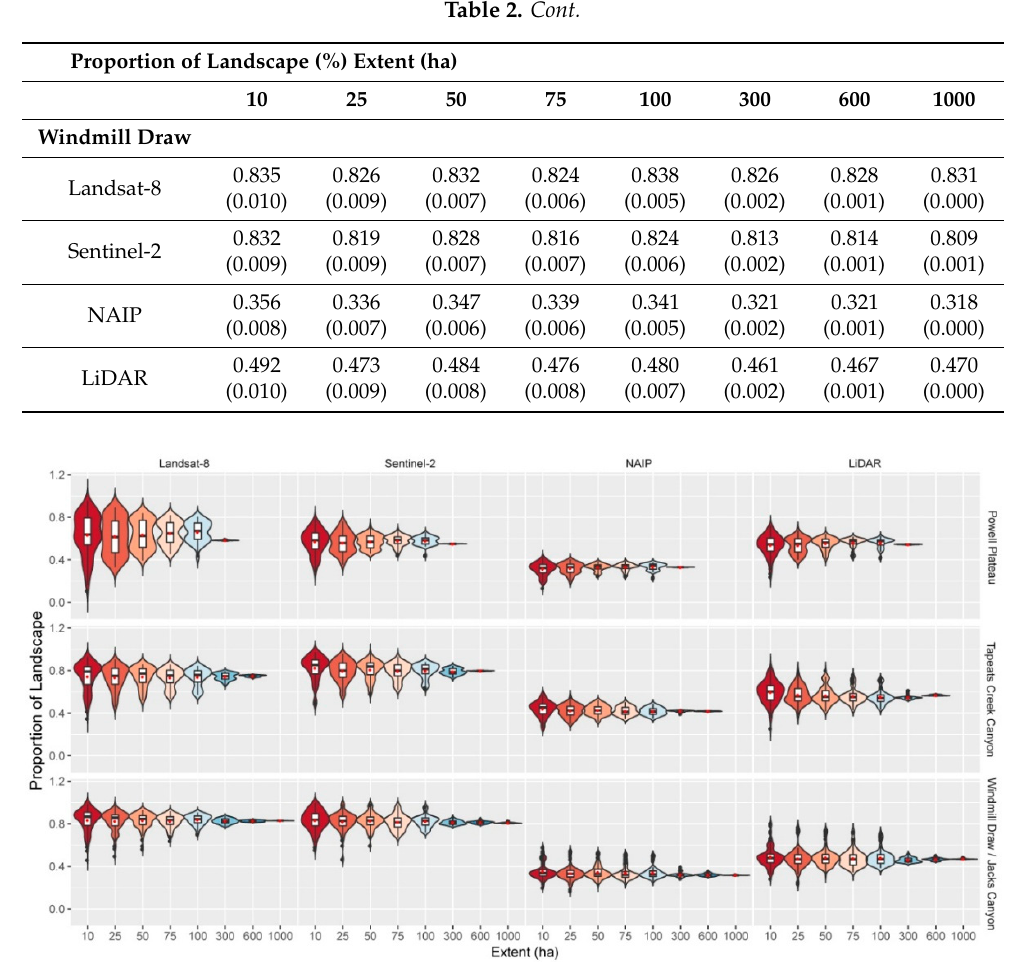
Figure 3. Violin plots (colored by extent and depicting probability density of the data at different values smoothed by a kernel density estimator), box-and-whisker plots (black and white), and mean (red dot) for the proportion of landscape (ha) under forested canopy cover for each landscape and data product (Landsat-8 30 m, Sentinel-2 10 m, NAIP 1 m, LiDAR 1 m), and across multiple spatial extents. Insets with rescaled y-axis provided for clarity.